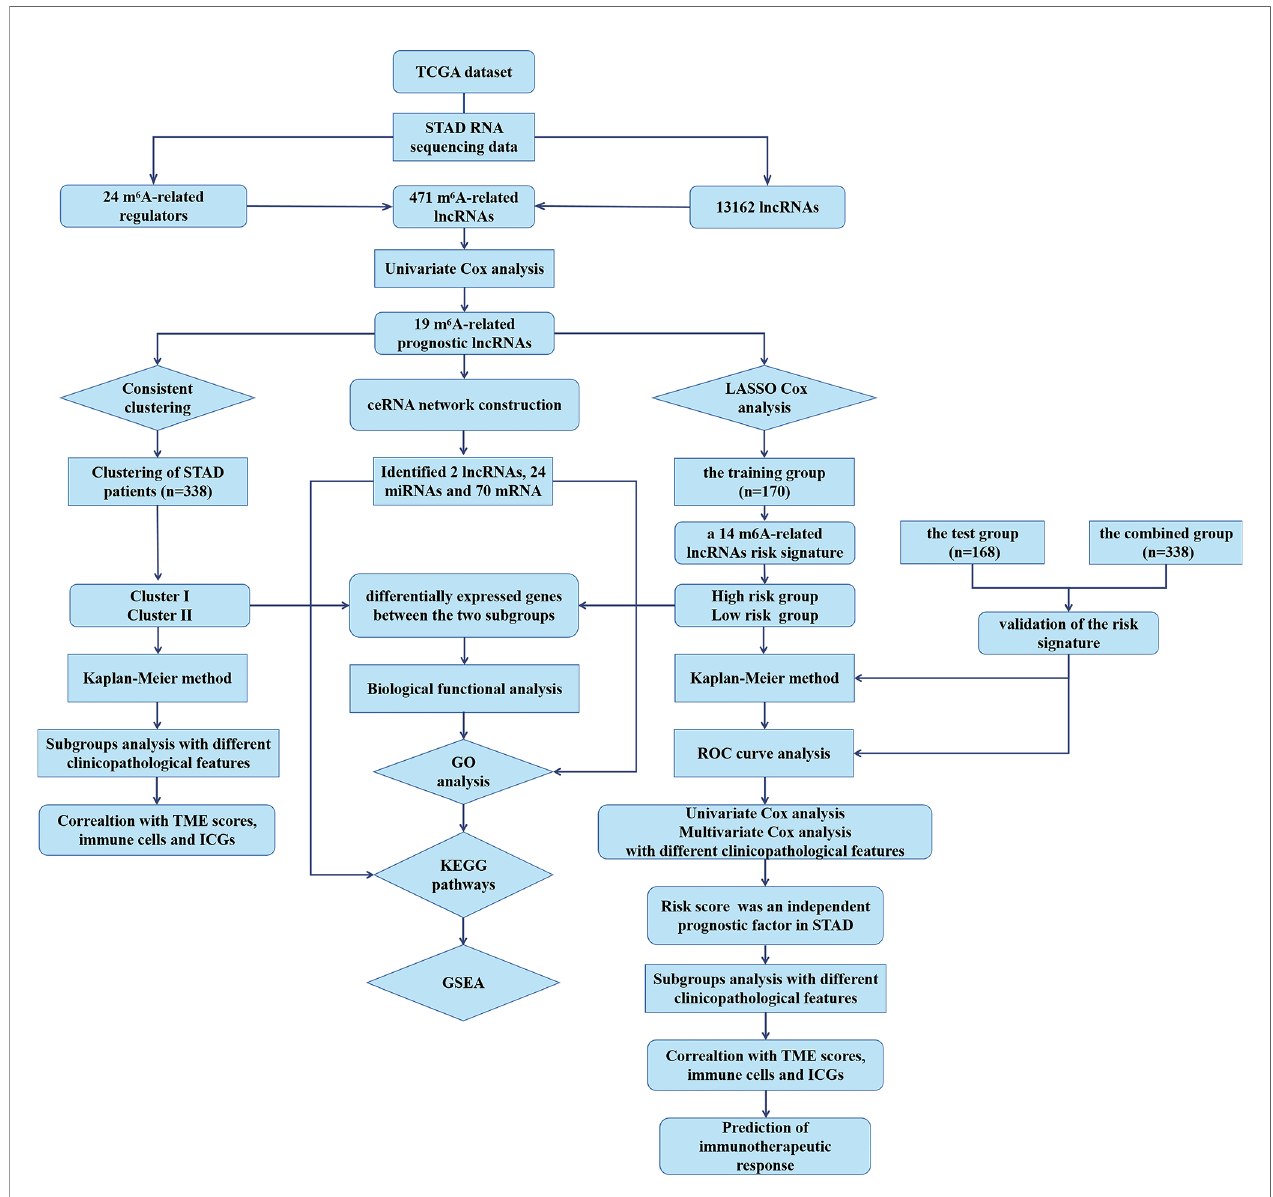
FIGURE 1 | The fl ow chart of the study design and